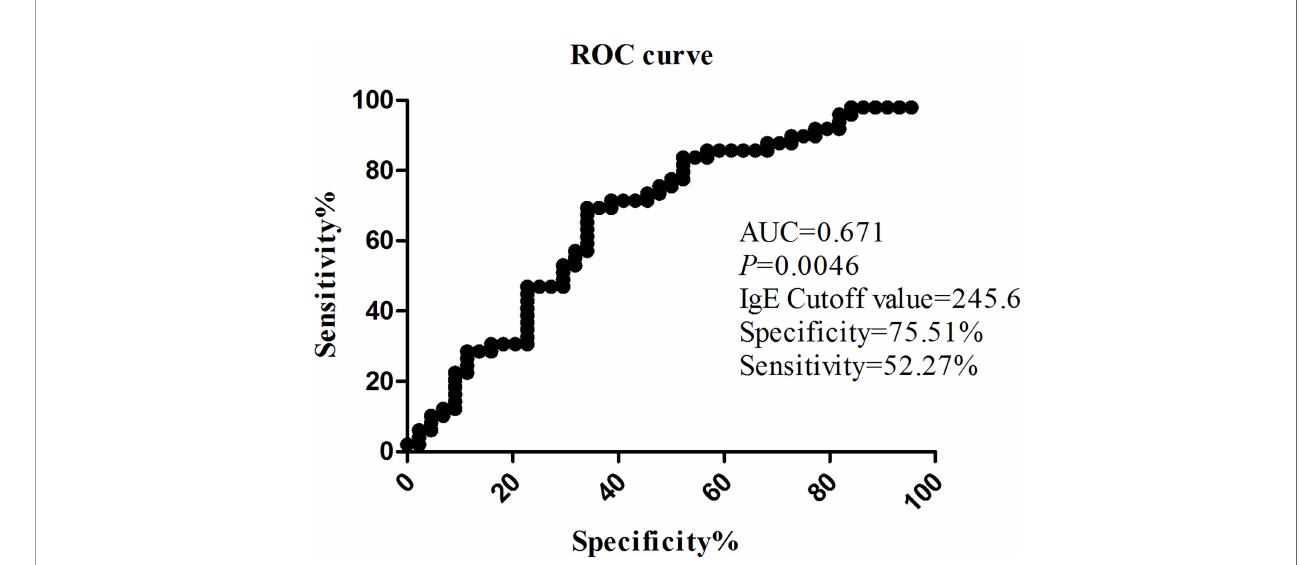
FIGURE 3 | The value on the receiver operating characteristic (ROC) curve of the IgE level between the complication group and the non-complication